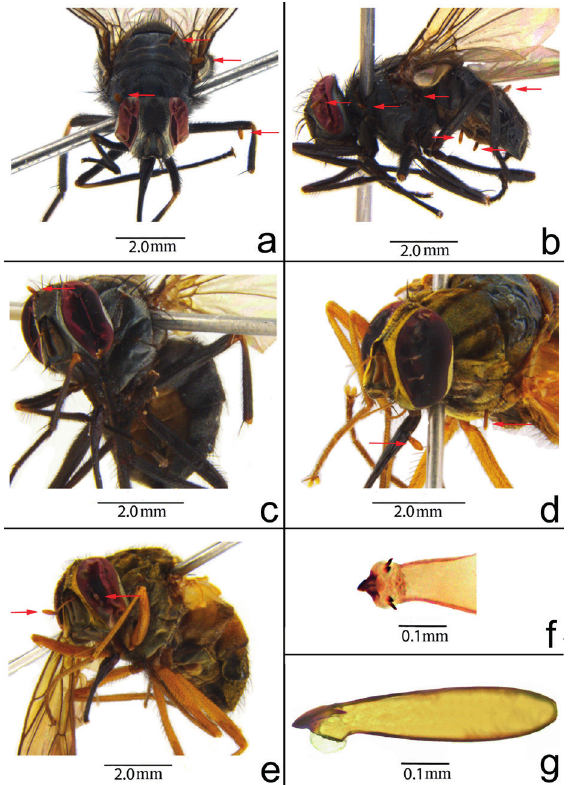
Figure 1 – a ) Lateral view of Stomoxys omega Newstead (ENT000027971, adult ♂); b ) Lateral view of Stomoxys omega Newstead (ENT000028668, adult ♀); c ) Lateral view of Stomoxys omega Newstead (ENT000027797, adult ♀); d ) Lateral view of Stomoxys taeniatus Bigot (ENt000028471, adult ♂); e ) Lateral view of Stomoxys taeniatus Bigot (ENT000028756, adult ♂); f ) Ventral view of the anterior part of the egg of Stylogaster nitens Brunetti; Figure g ) Lateral view of the egg of Stylogaster